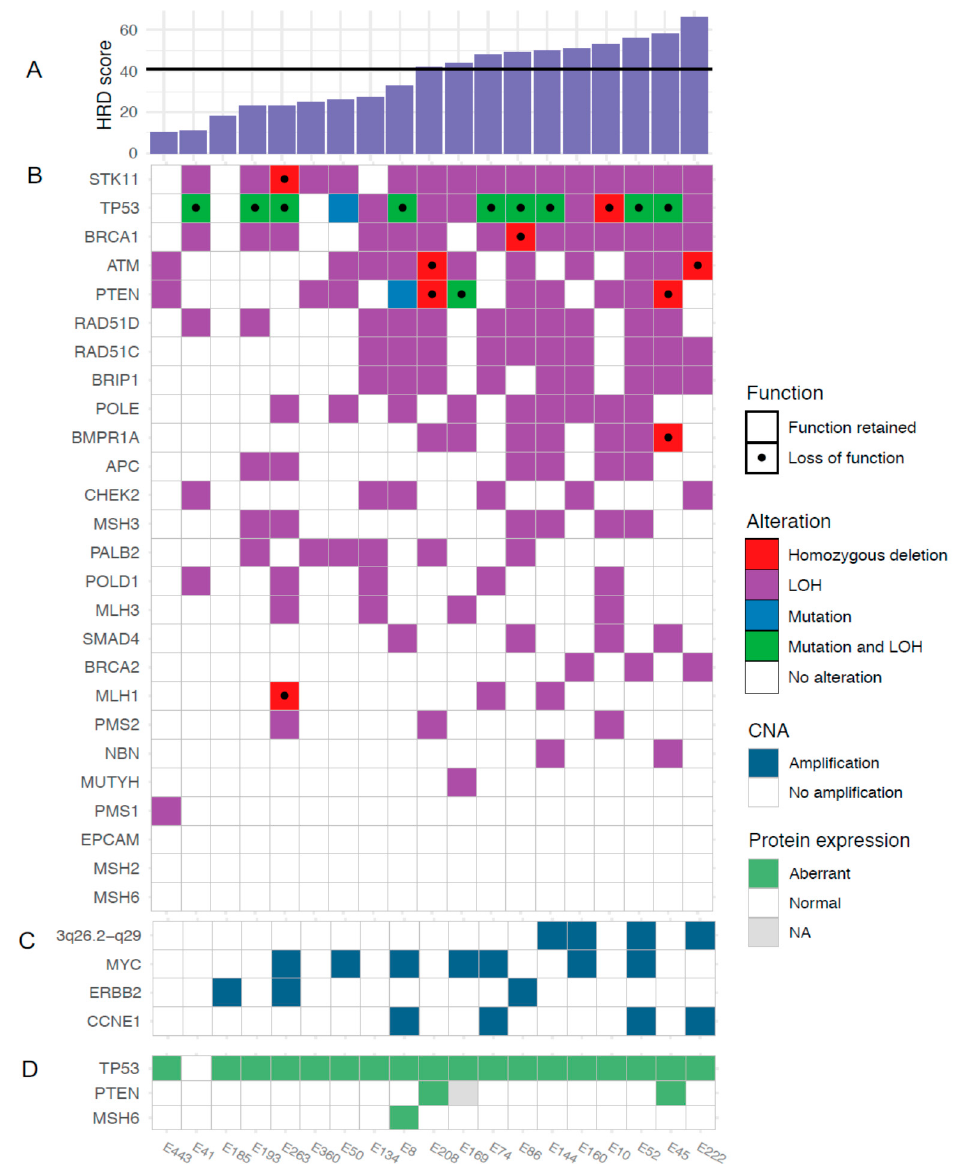
Figure 3. Somatic mutations and copy-number aberrations in relation to HRD score. ( A ) HRD scores, ( B ) genetic alterations, ( C ) amplifications, and ( D ) protein expression. ( B ) genetic alterations, ( C ) amplifications, and ( D ) protein